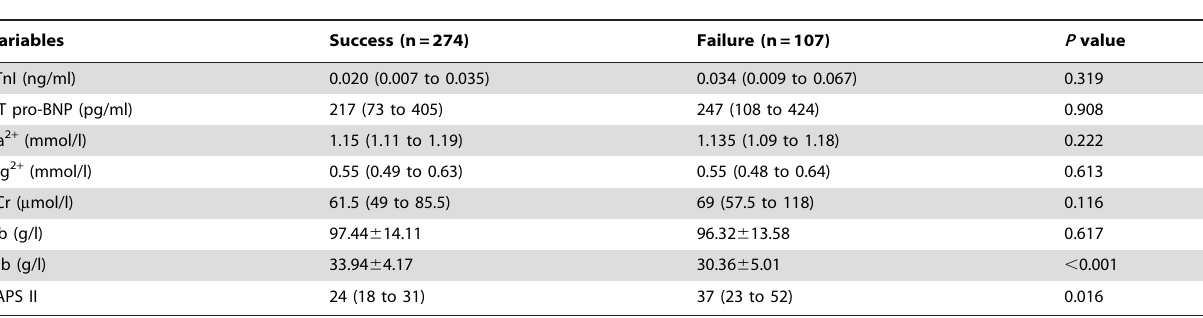
Table 4. Variables before